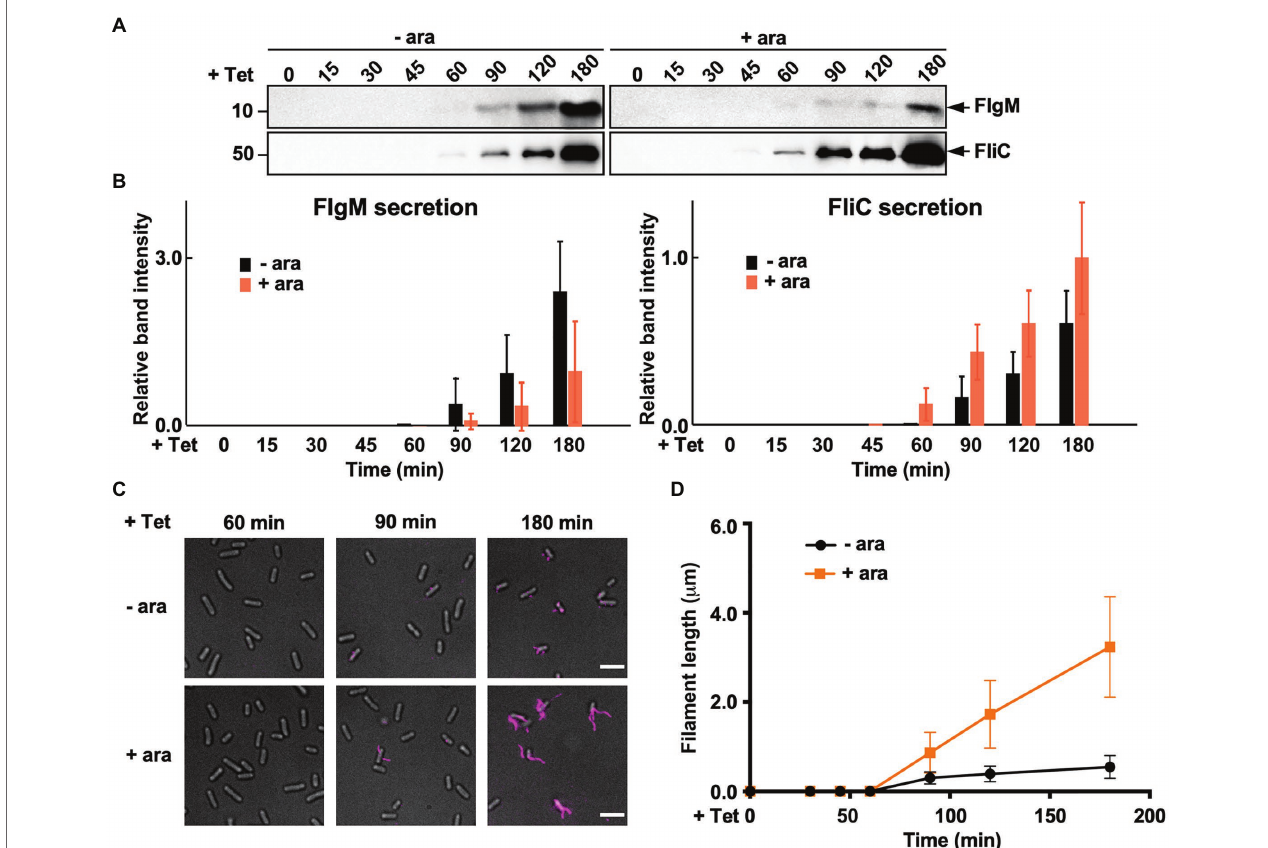
FIGURE 6 | Measurements of the secretion rates of FlgM and FliC using ∆ S/P araBAD - fliS cells containing a T-pop insertion. (A) Immunoblotting, using polyclonal anti-FlgM (upper panel) or anti-FliC (lower panel) antibody, of heat-treated cultures of ∆ S/P araBAD - fliS T-pop cells. The ∆ S/P araBAD - fliS T-pop cells were grown at 30 ° C in L-broth until the cell density reached an OD 600 of 0.5. After adding tetracycline with (+ara) or without ( − ara) arabinose, cell cultures were collected at 0, 15, 30, 45, 60, 90, 120, and 180 min and heated at 65 ° C for 5 min to depolymerize flagellar filaments into FliC monomers. Molecular mass markers are indicated on the left. (B) Relative extracellular levels of FlgM (left panel) and FliC (right panel). The density of each FlgM or FliC band on immunoblots was normalized for the level of FlgM and FliC in FliS + cells at 180 min. These data were the average of four independent experiments. Vertical bars indicate standard deviations. (C) Fluorescent images of the ∆ S/P araBAD - fliS T-pop cells. The cells were exponentially grown in L-broth. After adding tetracycline with or without arabinose, the cells were collected at the indicated time intervals, followed by labelling their flagellar filaments with a fluorescent dye. (D) Average length of flagellar filaments. Filament length was the average of 50 filaments. Vertical lines indicate standard deviations (also see Supplementary Table 3